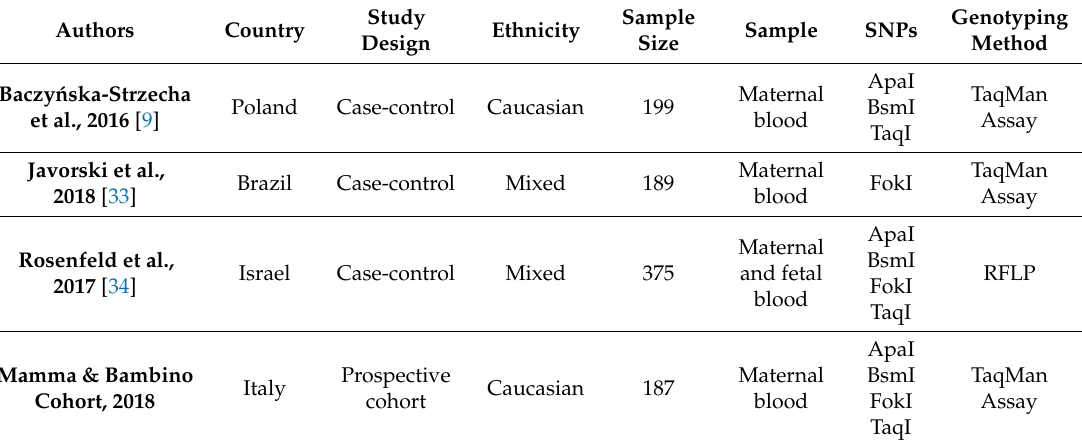
Abbreviations: SNP, single nucleotide